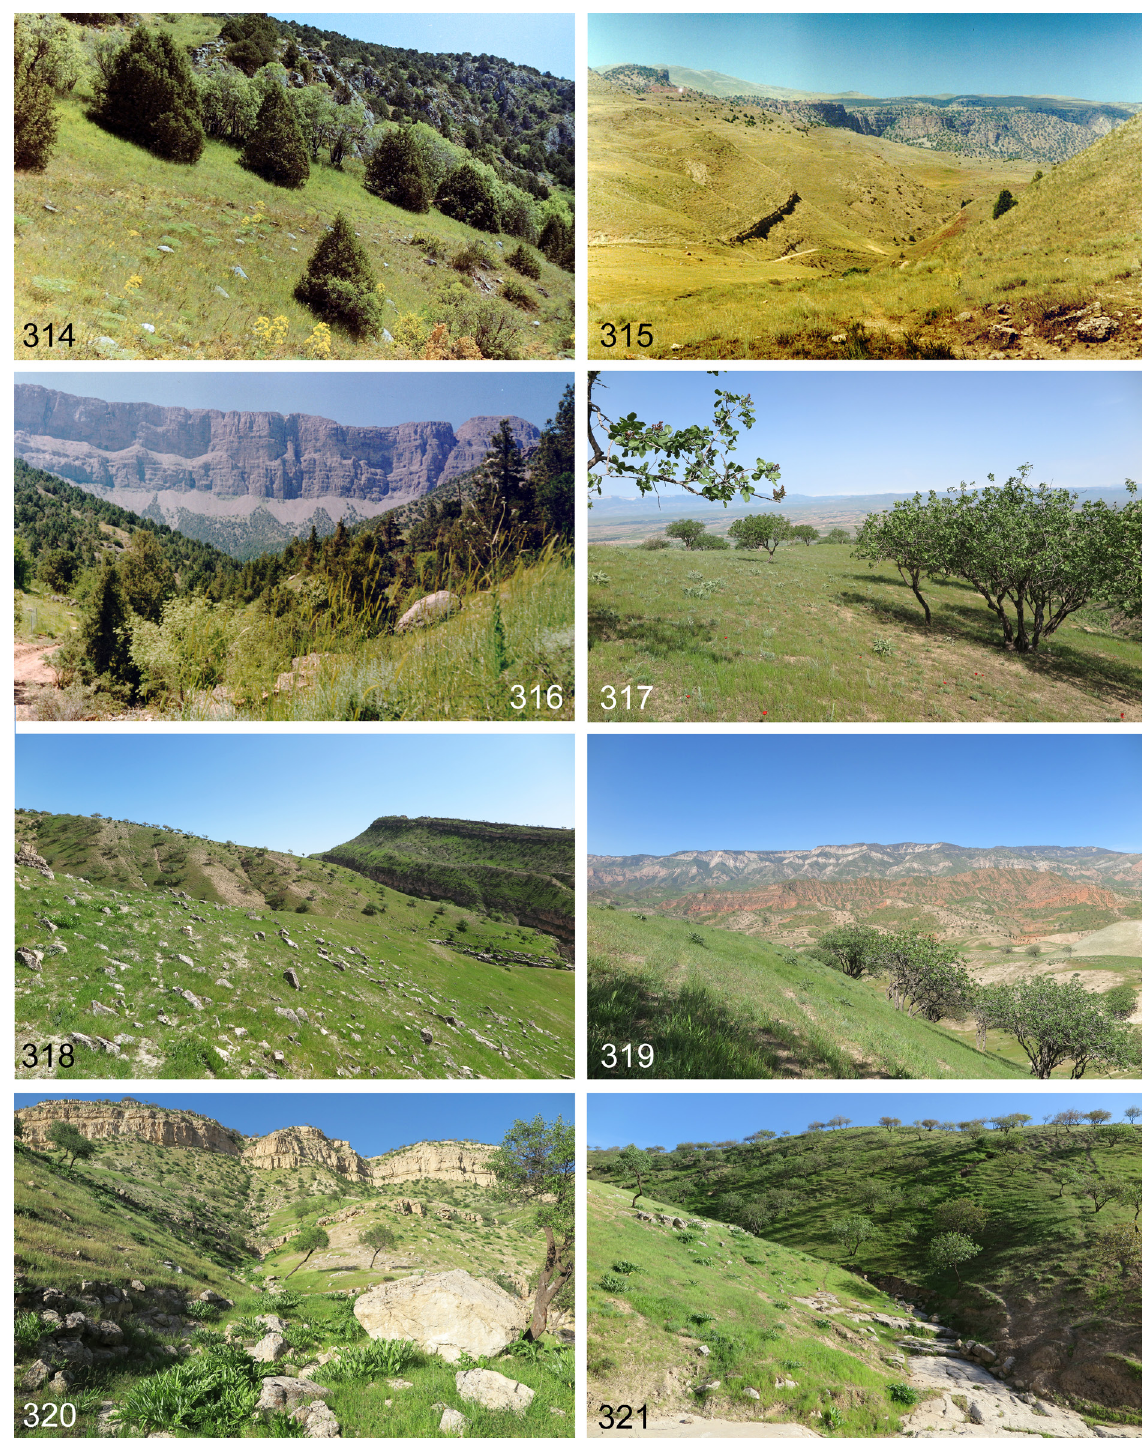
Figs 314–321. Anemesia spp., habitats of A. sogdiana sp. nov. (314–316), A. karatauvi (Andreeva, 1968) (317), A. oxiana sp. nov., A. castanea sp. nov., A. pallida sp. nov. and A. incana Zonstein, 2001 (318–321); Uzbekistan (334–336) and Tajikistan (317–321). 314–316 . Zeravshan Mts (Amankutan Pass), south-western Hissar Mts (near Akrabat Pass) and Kugitang Mts (Kampyrtepa), respectively. 317 . Foothills of Vahsh Karatau Mts. 318–321 . Surroundings